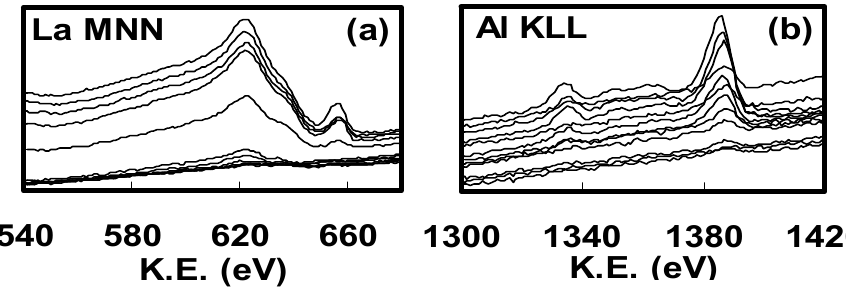
Figure 30. AES spectra along the diameter of the wafer for ( a ) La MNN and ( b ) Al KLL.